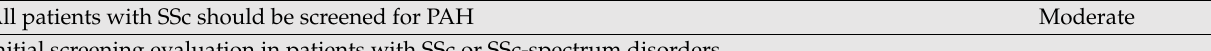
Table 2. Screening algorithm for SSc-PAH proposed in 2013 a .